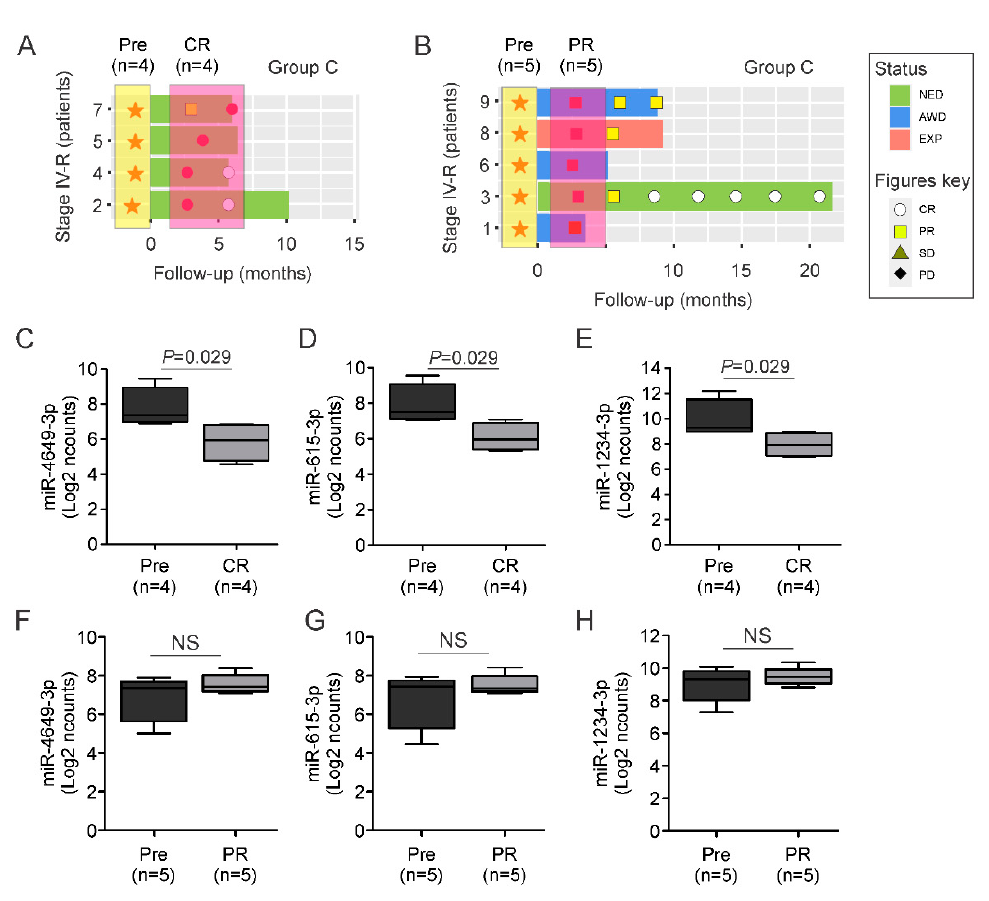
Figure 3. Validation of cfmiRs identified in assessing patient response to CIIs. ( A , B ) Disease status in stage IV patients who had a complete response ( A , CR) or partial response ( B , PR). Orange stars indicate pre-treatment (Pre) plasma samples. Red circles indicate blood collected in patients at CR. Red squares indicate blood collected in patients at PR. ( C – E ) Boxplots showing the changes in miR- 4649-3p ( C ), miR-615-3p ( D ), and miR-1234-3p ( E ) levels in patients who achieved a CR ( p values are